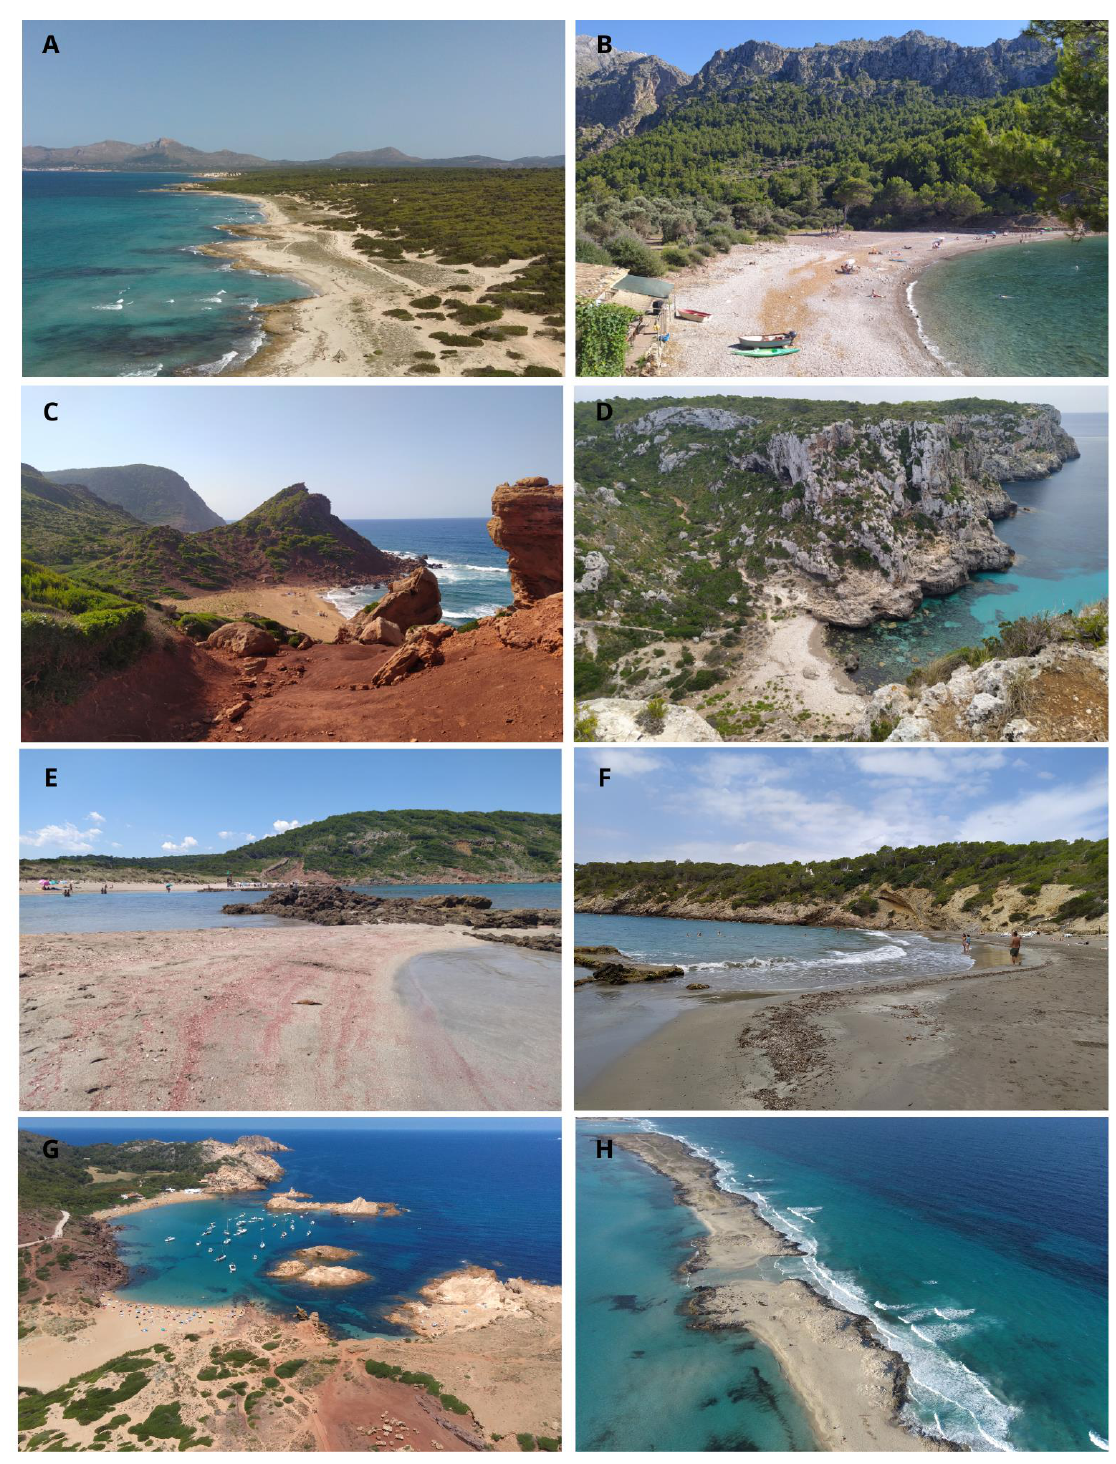
Figure 8. Natural scenic characteristics: fixed dunes and natural coastline of S’Arenal d’en Casat, Mallorca ( A ); mountainous landform at Cala Tuent (Puig-Major on the left), Mallorca ( B ); contrast of colors at Cala del Pilar, Menorca ( C ); cliff at Cala Llucalari, Menorca ( D ); sediment colors at Son Saura (Menorca) ( E ) and Cala Boix (Ibiza) ( F ); presence of reefs and islets at Calas Salair ó and Pregonda, Menorca ( G ); narrow barrier island, Punta Alta, Formentera ( H